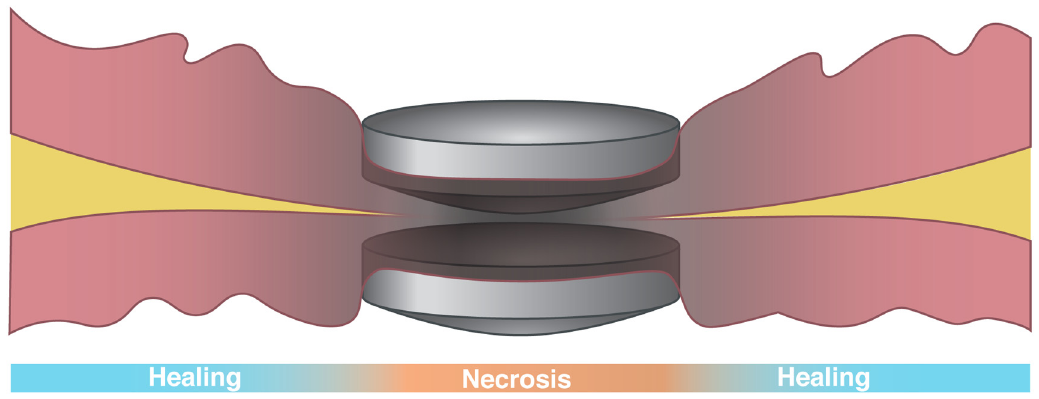
Figure 2. Connect ‐ EA TM device composed of two N52 ‐ grade magnets with a unique concave–convex surface that produces a pressure gradient in the intervening tissue compressed between the mag- nets. The maximal pressure in the center creates tissue necrosis, while allowing for tissue healing and epithelialization at the periphery, which forms a robust anastomosis with decreased stricture formation [53]. (Permission for use granted by Myka Labs, San Francisco, CA, USA.)